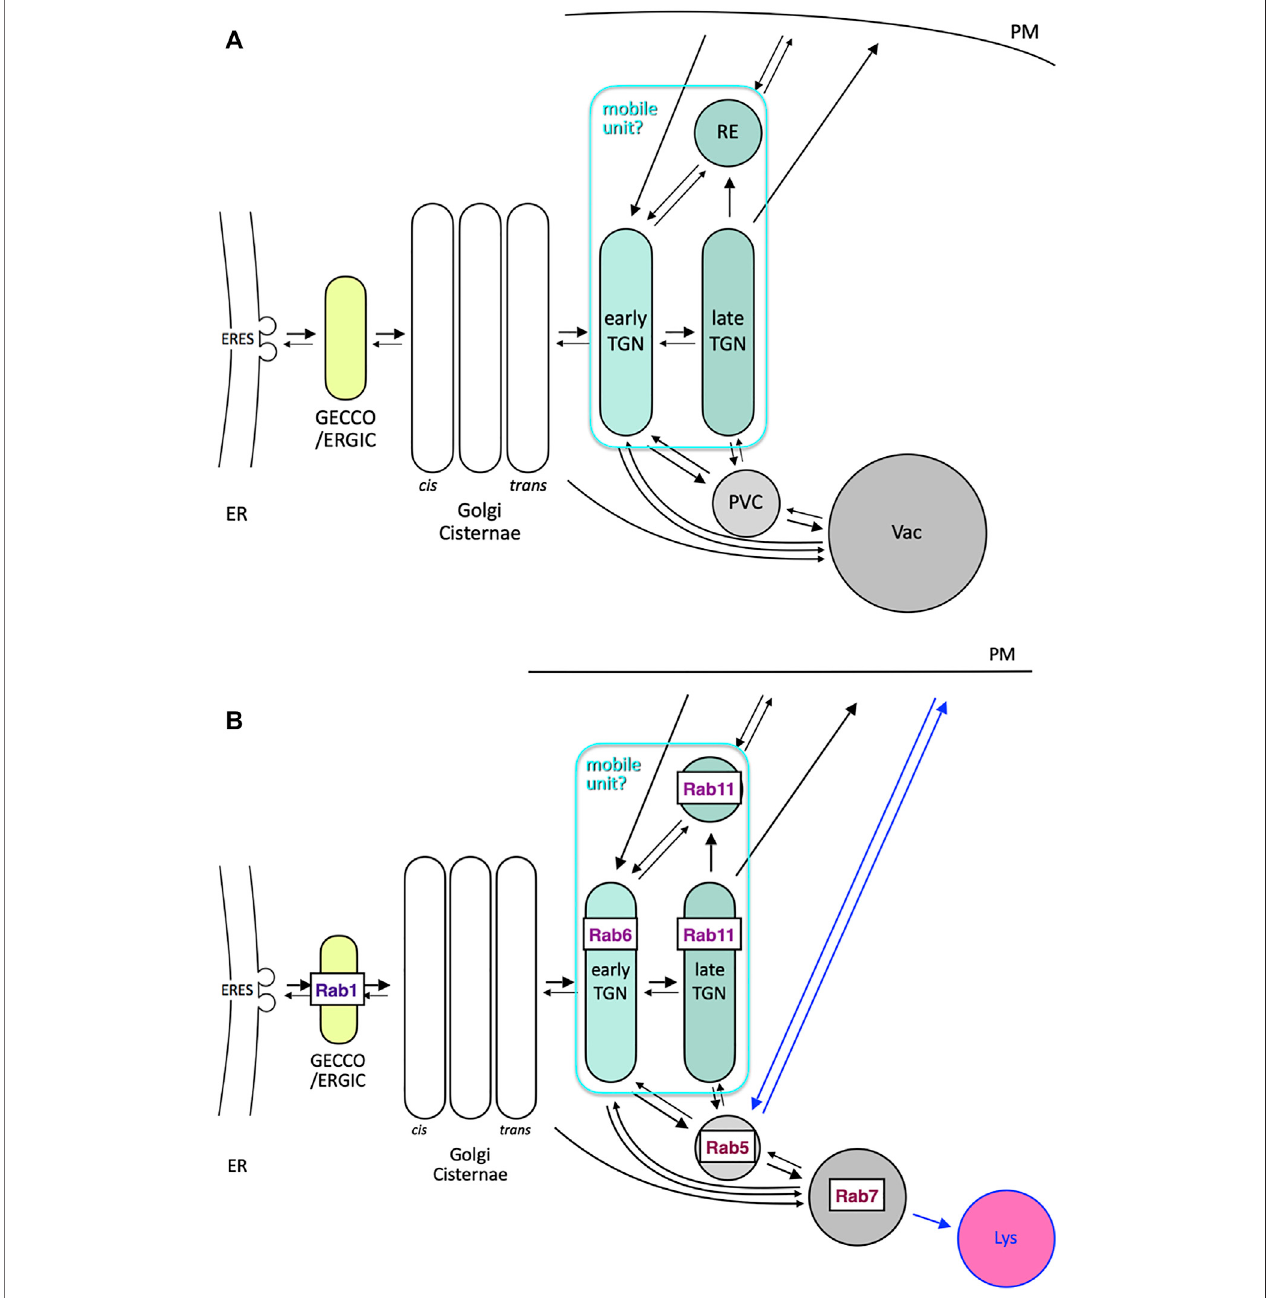
FIGURE6| Comprehensivemodelsoftraf fi ckingaroundGolgiandpostGolgi. (A) Traf fi ckingpathwaysaroundGolgianditsnext-doorneighbors(GECCO/ERGIC andTGN/RE)aswellaspost-Golgitraf fi ckingtovacuole(Vac) via prevacuolarcompartment(PVC).Arrowsaredrawninanattempttoexplaintheobservationsdescribed in this review. Note that early TGN, late TGN, and RE can behave together as a mobile unit, which takes Golgi-associated and Golgi-independent statuses. (B) Consideration of conserved Rab GTPases as signboards of compartments, which may be common to yeast, plant, and animal cells. Rab1 (Ypt1 in yeast and RABDsinplants)sitsonGECCO/ERGIC,Rab6(Ypt6inyeastandRABHsinplants)isprobablyagoodmarkerofearlyTGN,andRab11(Ypt31/32inyeastandRABAsin plants)ispresentinlateTGNandRE.ThecasesofRab5(Vps21inyeastandRABFsinplants)andRab7(Ypt7inyeastandRABGsinplants)arecomplicated.Theymark PVC (MVB) and vacuole, respectively, in yeast and plant cells, but are considered to reside in early and late endosomes, respectively, in mammalian cells (see also Table 1 ). Blue arrows, i.e., back and forth between plasma membrane and Rab5 compartment and from Rab7 compartment to lysosome (Lys), could be considered inventions in